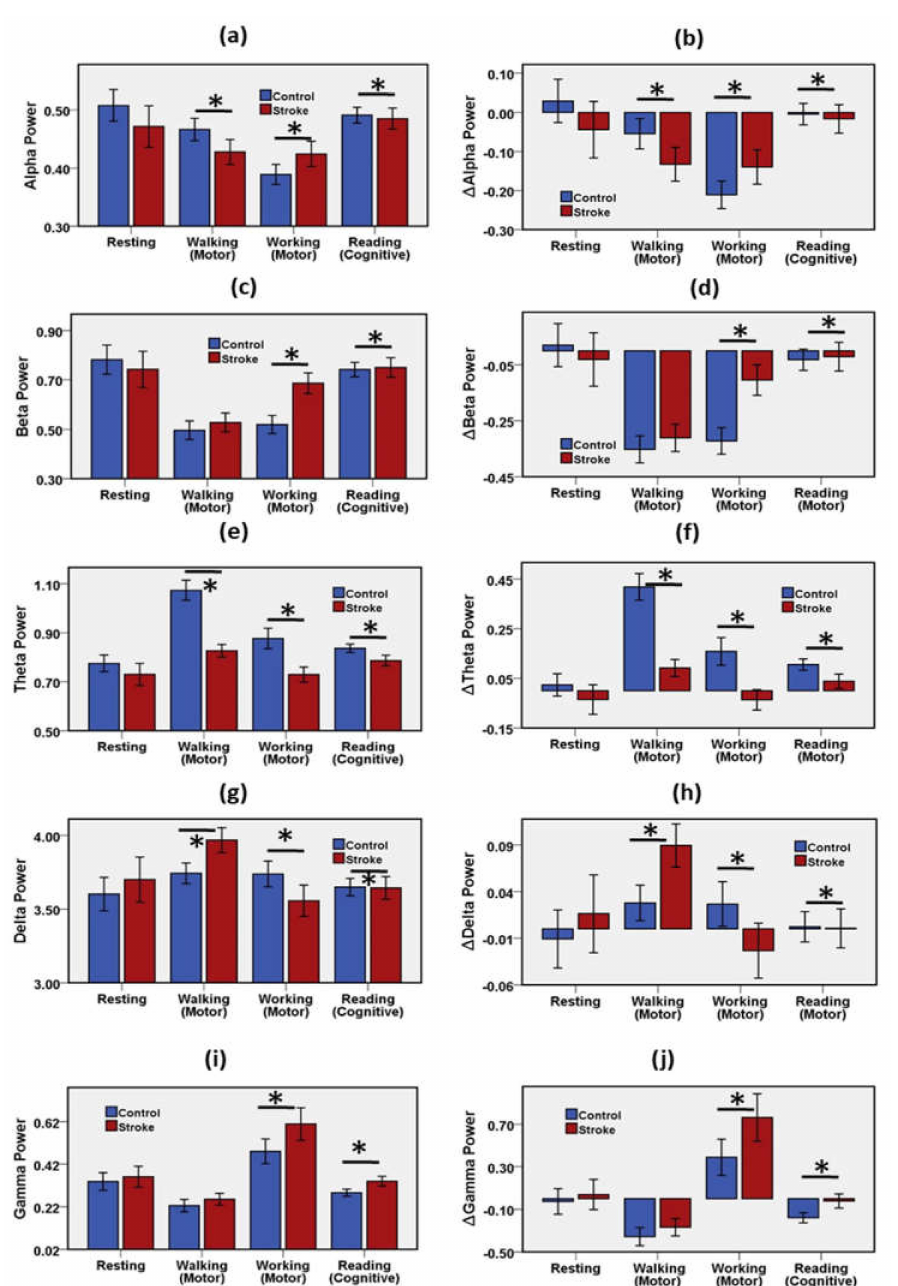
Figure 3. Mean and error bar of ( a ) RP Alpha, ( b ) change of Alpha relative to baseline, ( c ) RP Beta, ( d ) change of Beta relative to baseline, ( e ) RP Theta, ( f ) change of Theta relative to baseline, ( g ) RP Delta, ( h ) change of Delta relative to baseline, ( i ) RP Gamma, ( j ) change of Gamma relative to the baseline of the stroke group and the control group during resting, motor, and cognitive tasks. Error bar shows 95% confidence interval. * ( p < 0.05) indicates a significant difference. Resting state was considered as baseline. RP = Relative